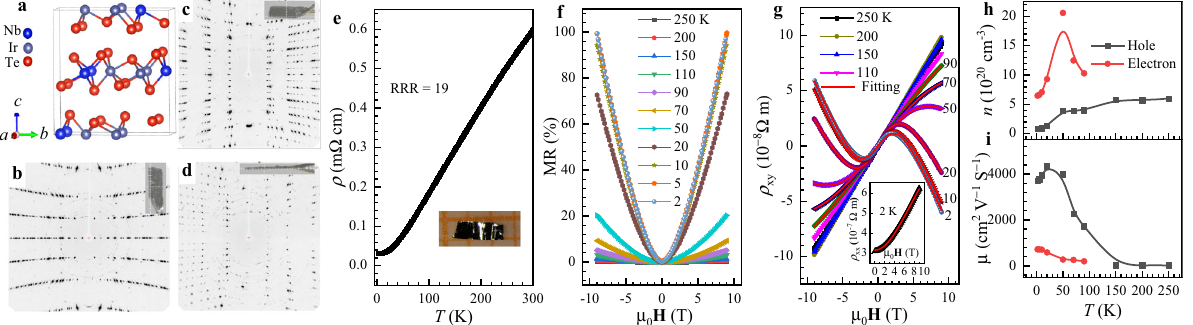
Fig. 1 Crystal structure and transport properties at ambient pressure. a The schematic crystal structure of NbIrTe 4 . b – d The SXRD patterns on a -axis, b -axis, and c -axis. The insets are the optical picture of corresponding direction. e Resistivity ρ ( T ) at ambient pressure. f , g Magnetoresistance MR( B ) and Hall resistivity ρ xy ( B ) at selected temperatures. The inset shows the magneto-resistivity ρ xx ( B ) curve at 2 K. The red solid lines represent the fi tting according to two-band model. h , i The extracted carrier density and mobility with respect to